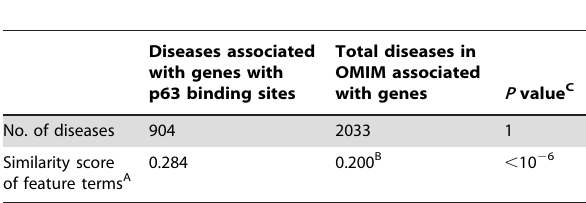
Table 1. Diseases associated with genes containing p63 binding sites.